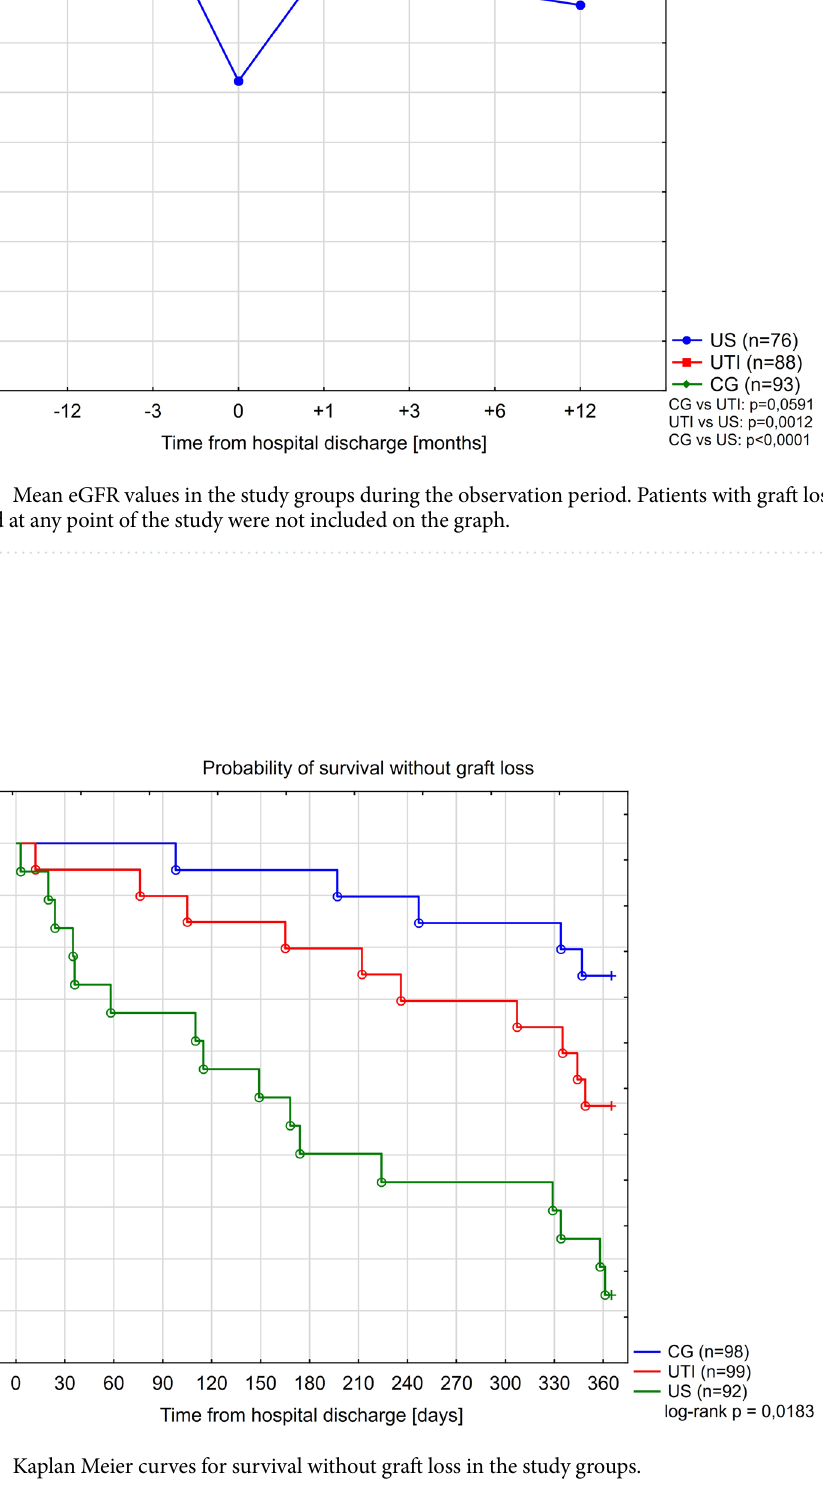
Figure 4. Kaplan Meier curves for survival without graft loss in the study